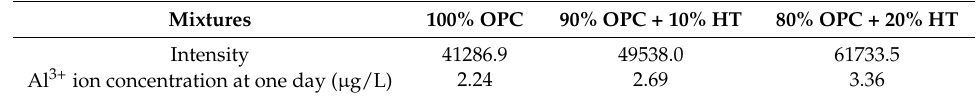
Table 3. Al 3+ ion concentration after one